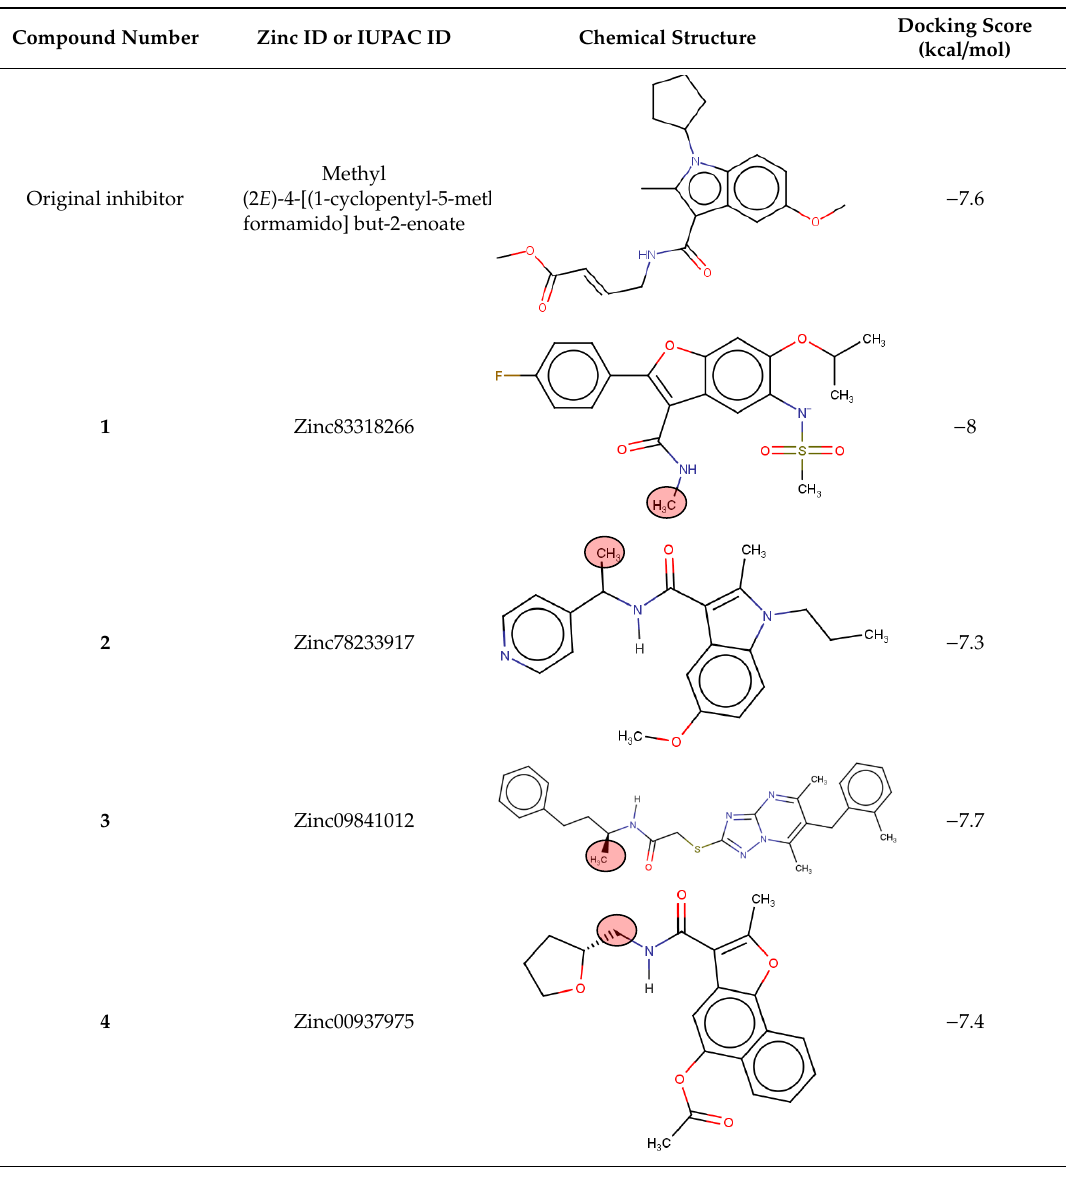
Table 2. Four compounds that successfully passed the assigned filters. The connecting points with the covalent part of the model are highlighted in